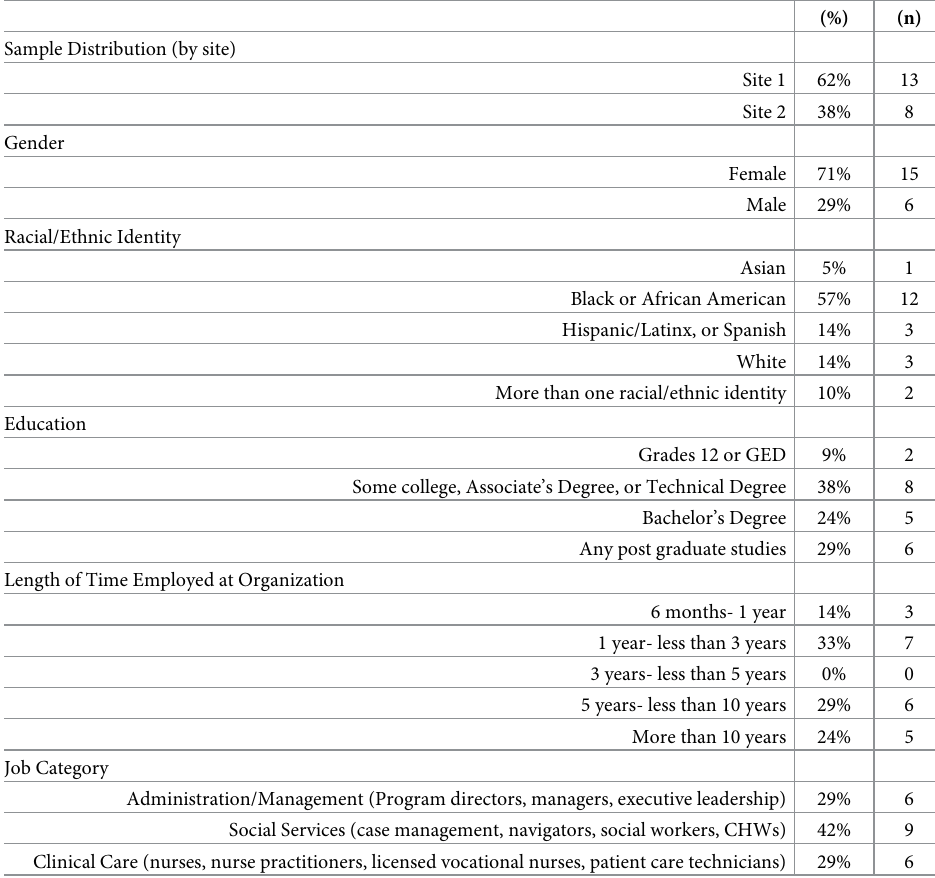
Table 1. Demographic characteristics of study